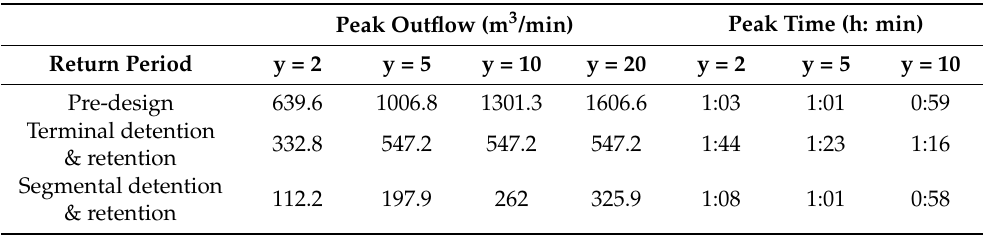
Table 7. Peak outflow at O7 and time to the peak outflow of the pre-design scheme, Scheme S and Scheme T in different return